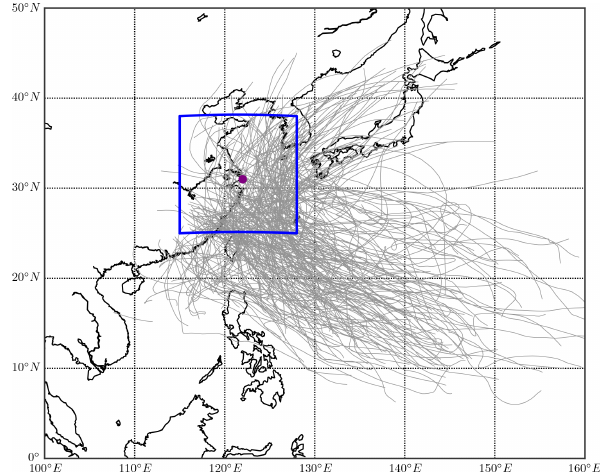
Figure 2. Location map for the area of interest. Grey lines indicate major historical typhoon tracks within the region. Blue box indi- cates the selection